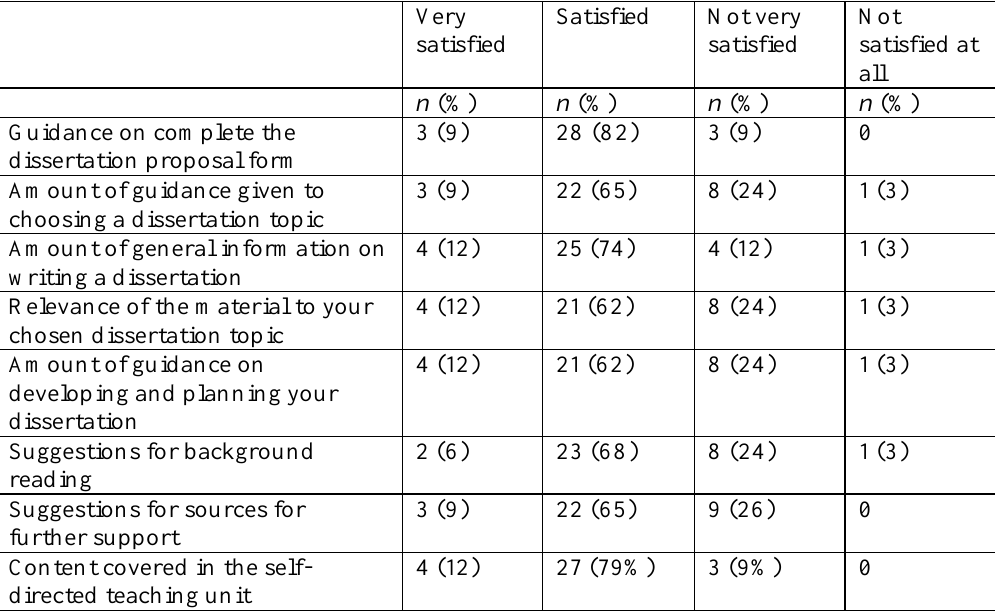
Satisfaction with Guidance on Selecting and Writing the Dissertation